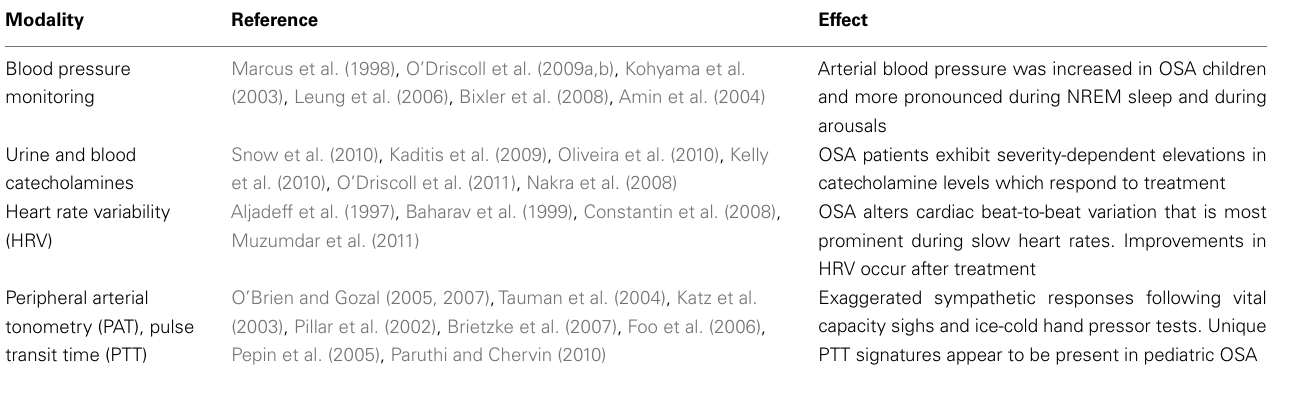
Table 2 | Summary of autonomic nervous system alterations in children with